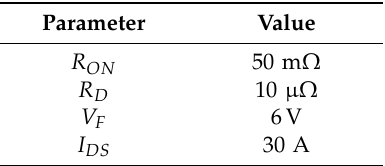
Table 1. Gallium Nitride (GaN) FET parameters.